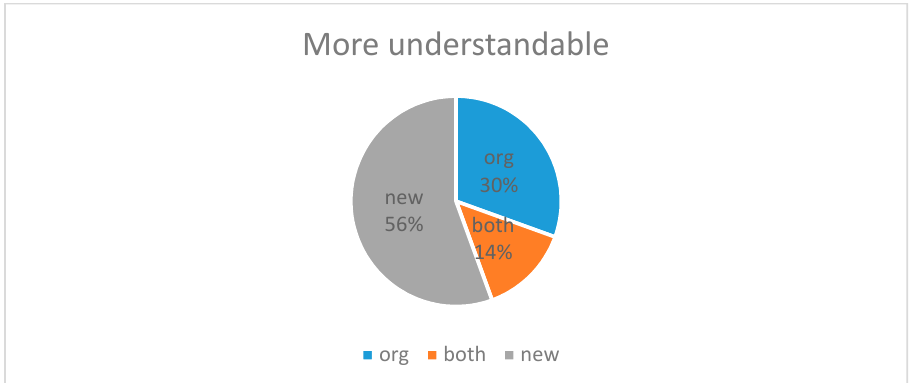
Figure 22. Result for the question: which was more understandable ? Where “org” is an original comment from the sample.